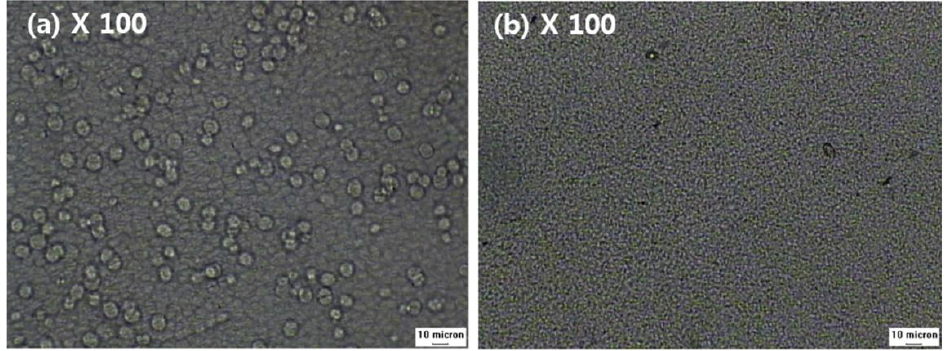
Figure 6. Thermal-optical microscope images of PVDF with and without NA11 during isothermal crystallization: ( a ) The image of sample #1 after 5 min at 130 °C, ( b ) The image of sample #1N after crystallization: ( a ) The image of sample #1 after 5 min at 130 ◦ C, ( b ) The image of sample #1N after 5 min at 130 °C. 5 min at 130 ◦